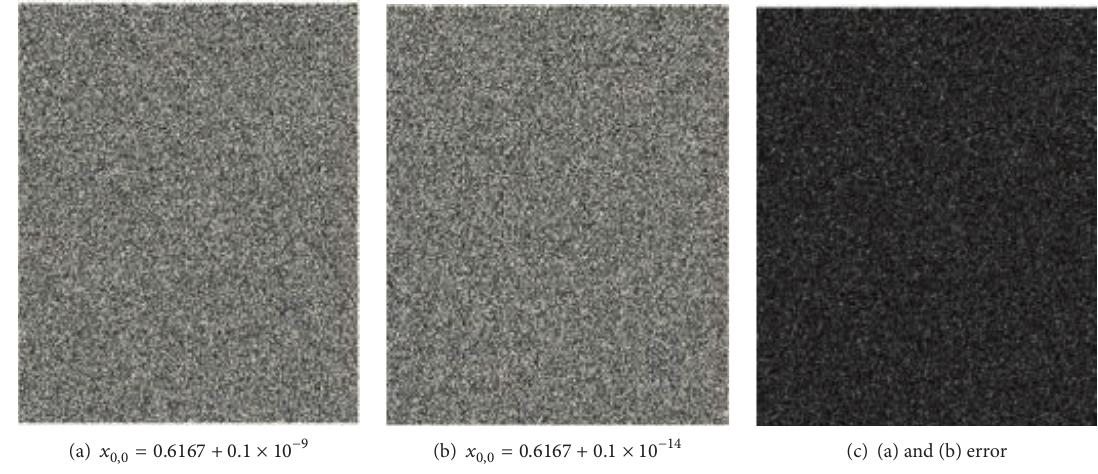
Figure 7: Wrong decryption keys under the image and the difference between them.